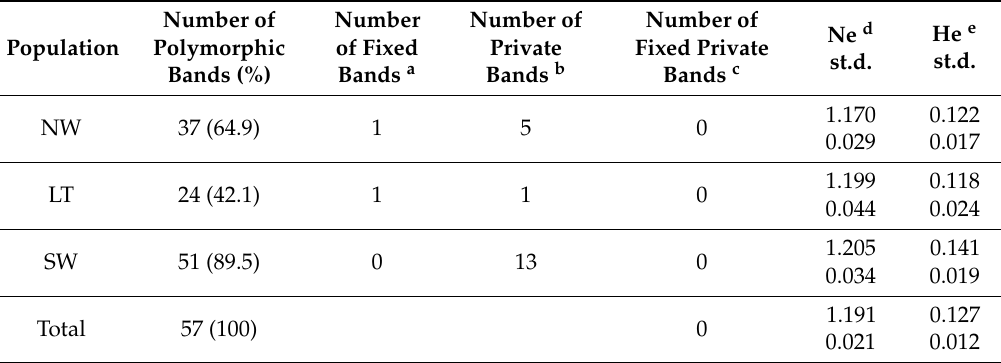
Table 2. Descriptive population statistics from di ff erent sampling